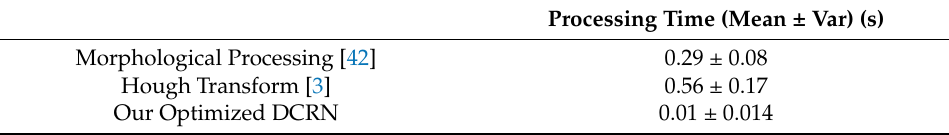
Table 9. Our proposed DCRN approach for building orientation angle estimation processing time results vs.the previous traditional image processing methods.